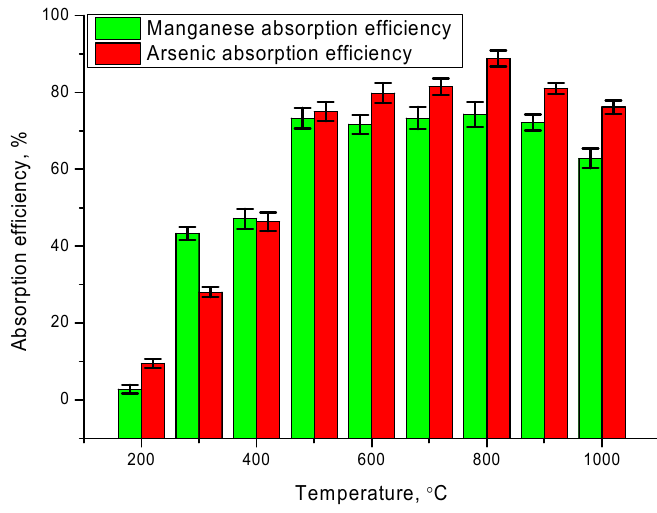
Figure 5. Absorption efficiency diagram of manganese and arsenic from aqueous solutions.